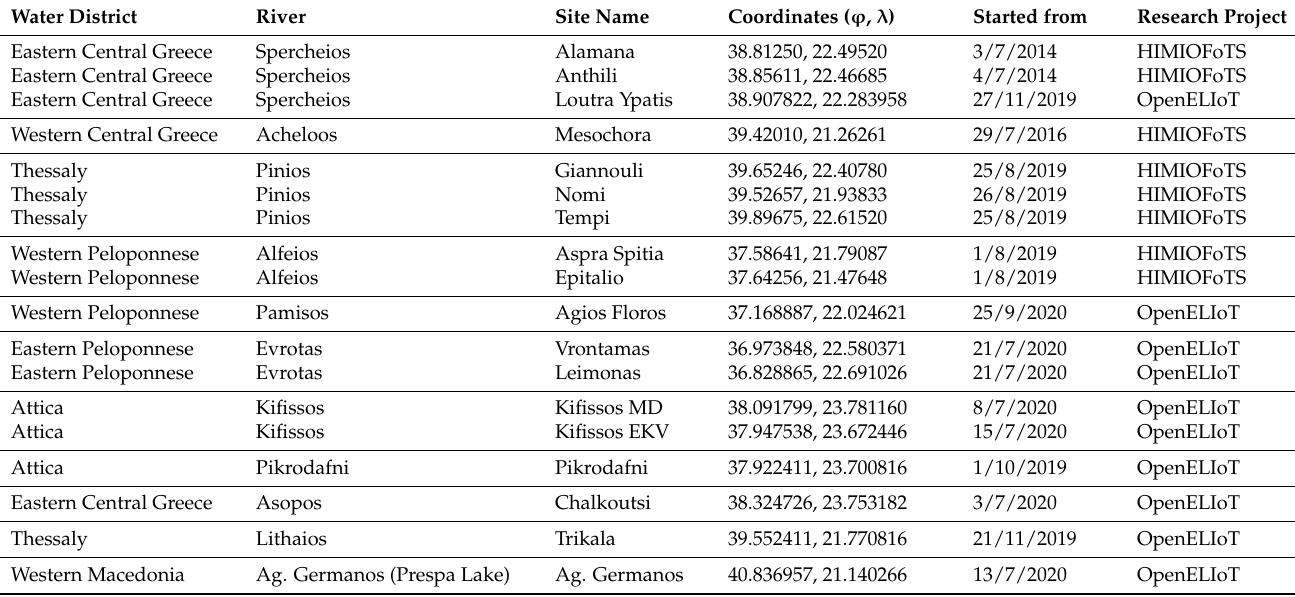
Figure 2. Spatial distribution of HCMR water quality monitoring network in selected Greek rivers up to December 2020: ( a ) the station in Ag. Germanos stream, ( b ) the stations in Acheloos, Lithaios, Pinios and Spercheios rivers, ( c ) the stations in Asopos and Kifissos rivers and in Pikrodafni stream and ( d ) the stations in Alfeios, Evrotas and Pamisos rivers. Table 2. The HCMR automatic water quality monitoring stations up to December